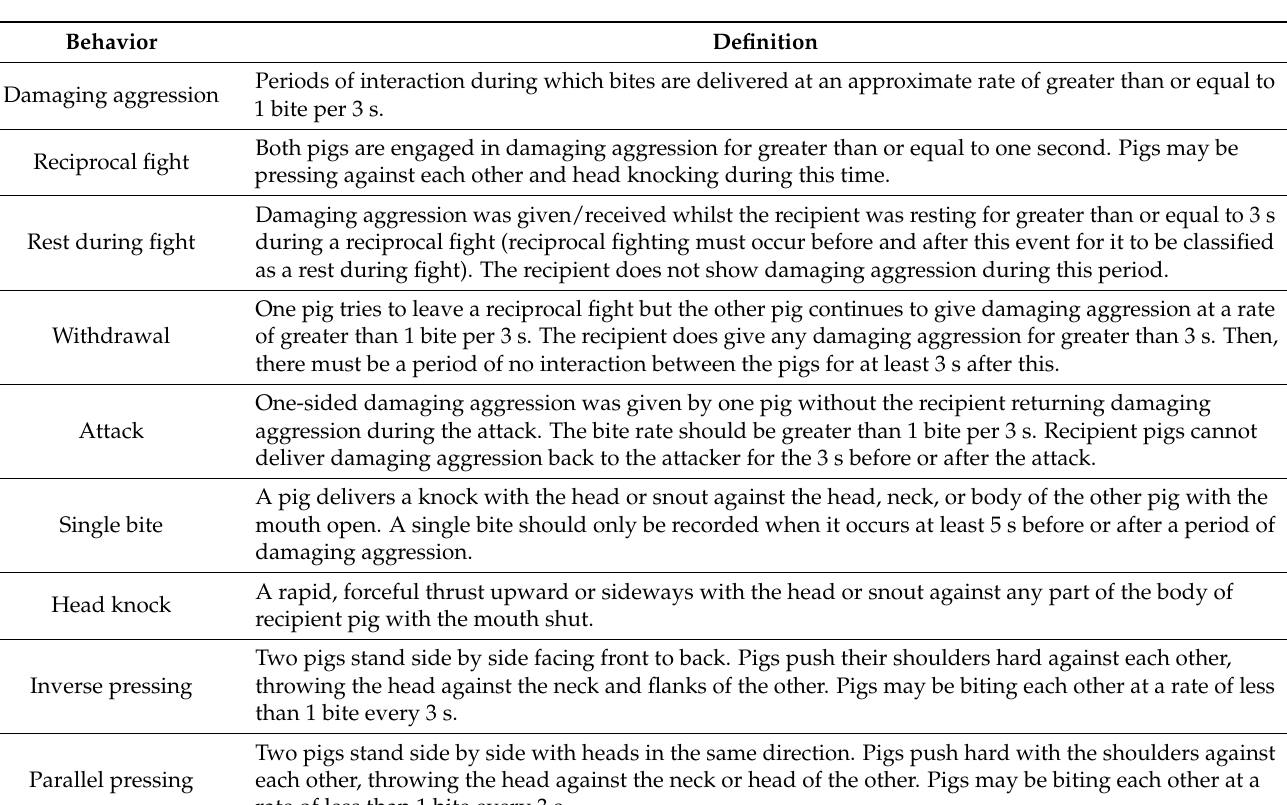
Table 1. Ethogram of aggressive